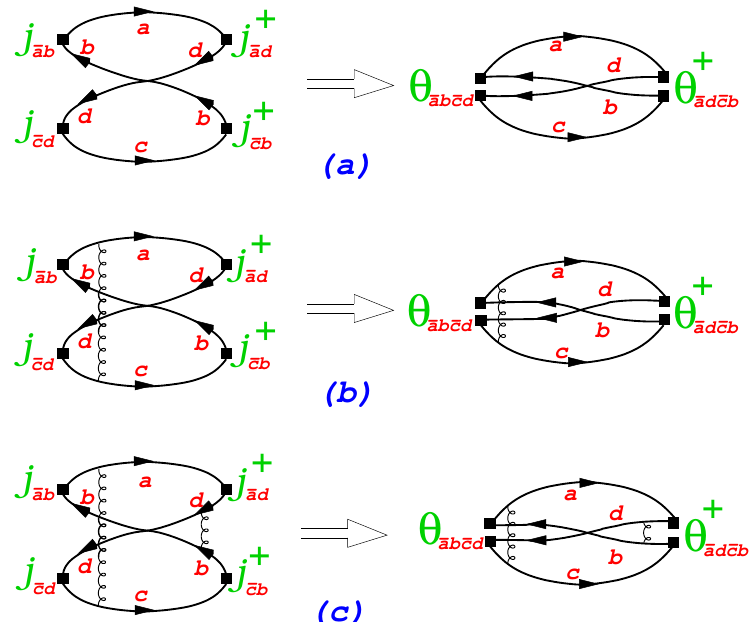
Figure 3. Definitely flavor-exotic four-current correlation function (7) of flavor- rearranging type ( left ) and ( right ) its contraction (8) to two-point correlation function of tetraquark interpolating opera- tors (6) [30,31]. Representative contributions of lowest perturbative orders: ( a ) O ( α 0 s ) ; ( b ) O ( α s ) and ( c ) O ( α 2 s ) .